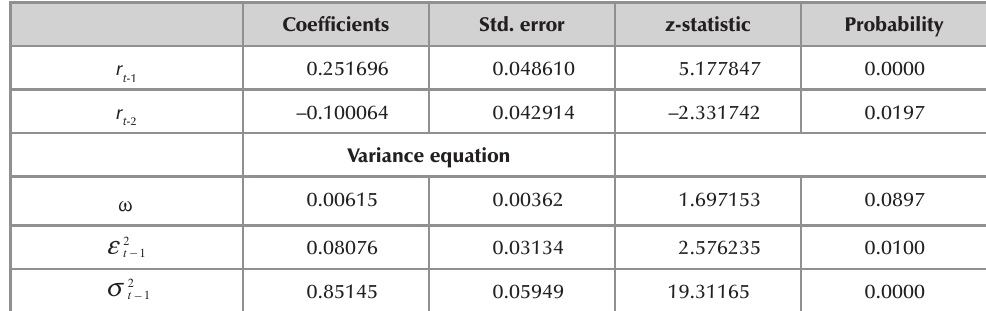
Estimation of a AR(2)-GARCH(1,1) variance